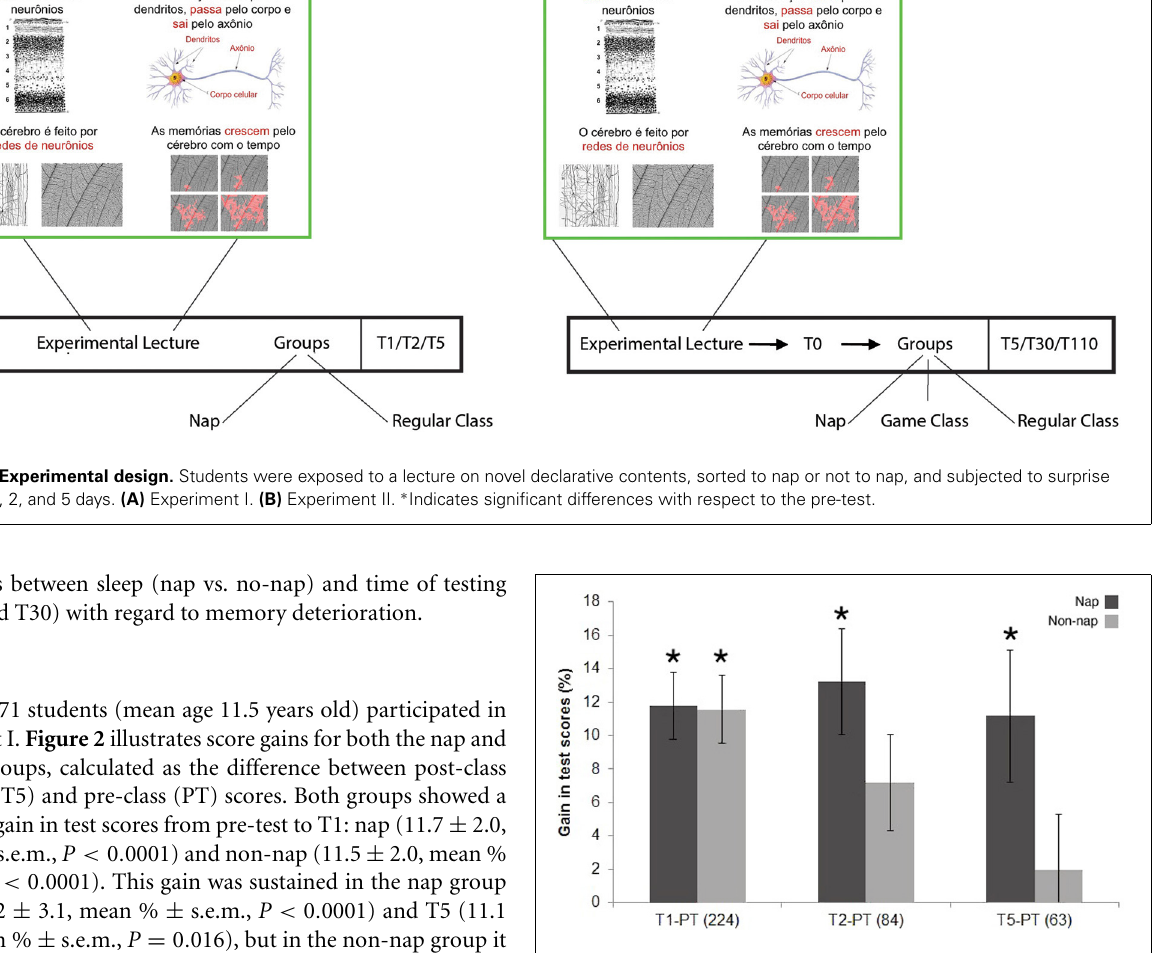
FIGURE 2 | Experiment I—Gains in tests scores between pre- and post-tests applied at 1, 2, or 5 days after learning. Nap ( N = 191, black bars) and non-nap ( N = 180, gray bars) groups. Numbers in parenthesis indicate N assessed at each post-test day. Asterisk for P < 0 . 05.